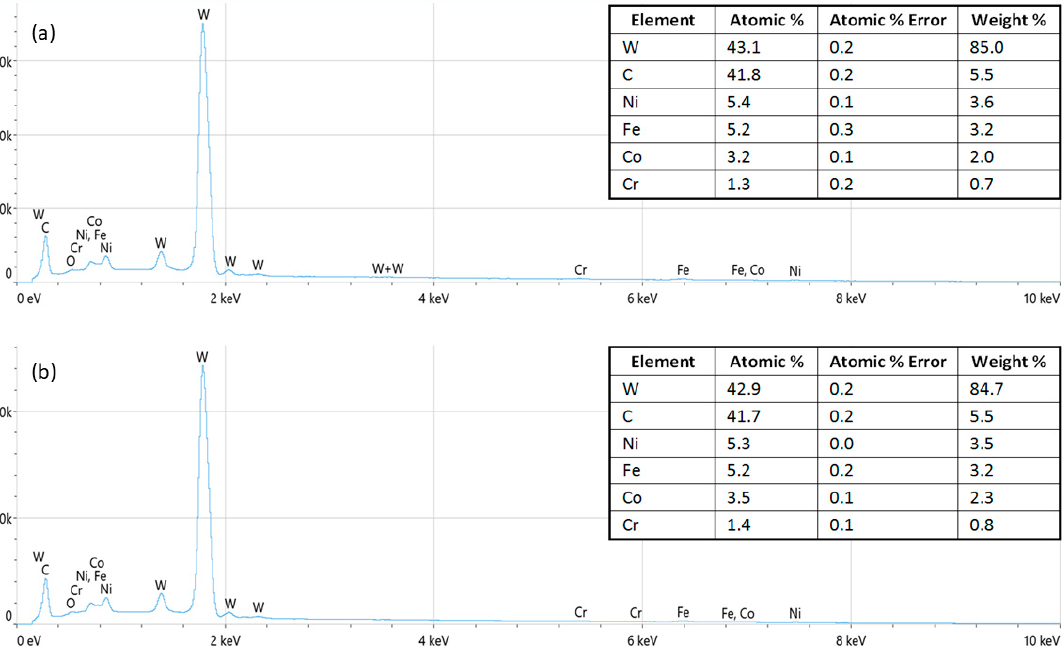
Figure 3. EDS spectra of the WC–9FeNiCo–1Cr 3 C 2 –0.5NbC sample ( a ) before and ( b ) after the corrosion process.